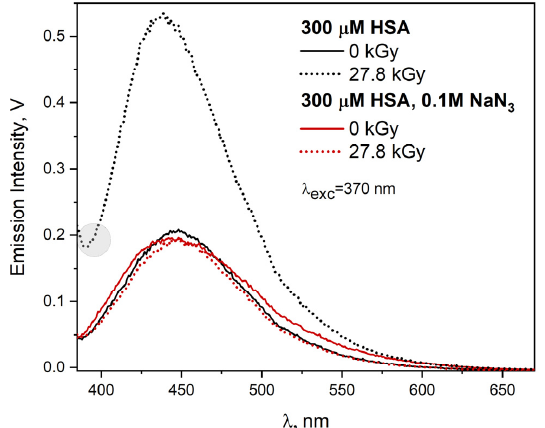
Figure 21. Emission spectrum of neat HSA solution (300 µM) and HSA solution containing NaN 3 (0.1 M). Emission spectra of N 2 O-saturated buffer solution of HSA (300 µM) and containing NaN 3 (0.1 M), obtained for irradiation dose 27.8 kGy. The excitation wavelength was 370 nm.